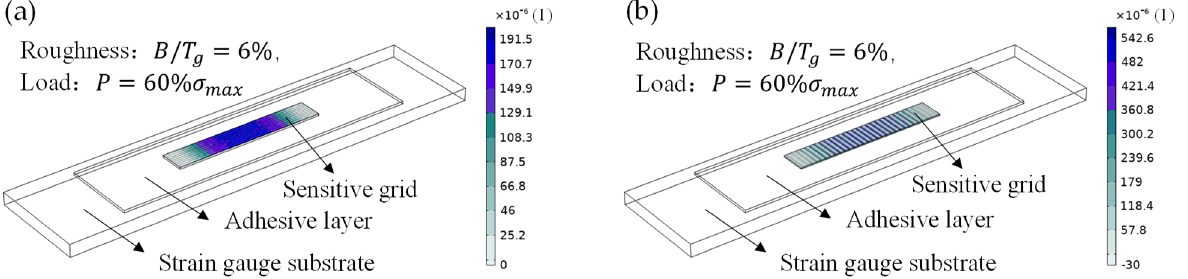
Figure 9. Creep strain distribution for a longitudinal ( a ) and transverse ( b ) profile mode of sensitive grids.